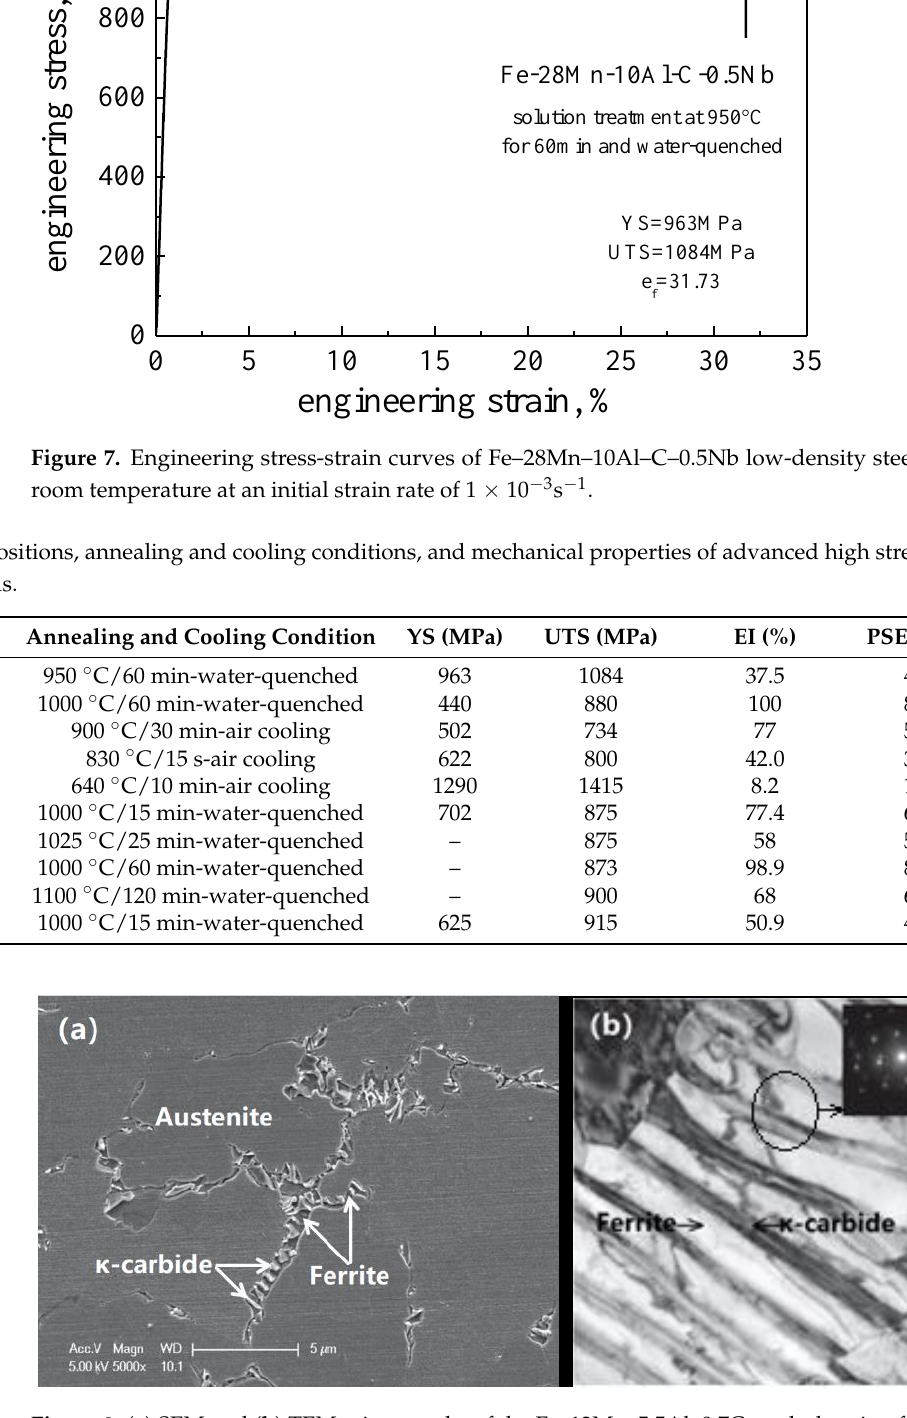
Figure 8. ( a ) SEM and ( b ) TEM micrographs of the Fe – 12Mn – 5.5Al – 0.7C steel, showing ferrites and κ -carbides at the boundaries of austenite grains in [27]. The true stress ( σ )-true strain ( ε ) curve of the steel is presented in Figure 9 with the corresponding strain hardening rate (d σ /d ε ). It can be seen from the results